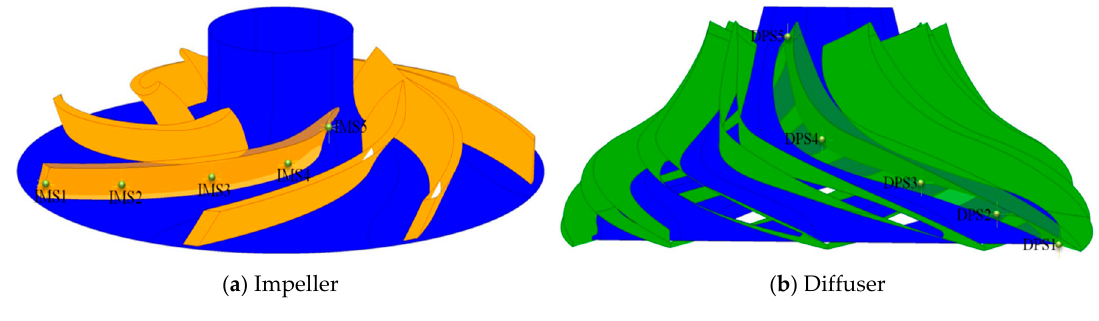
Figure 3. Location of the monitoring point.